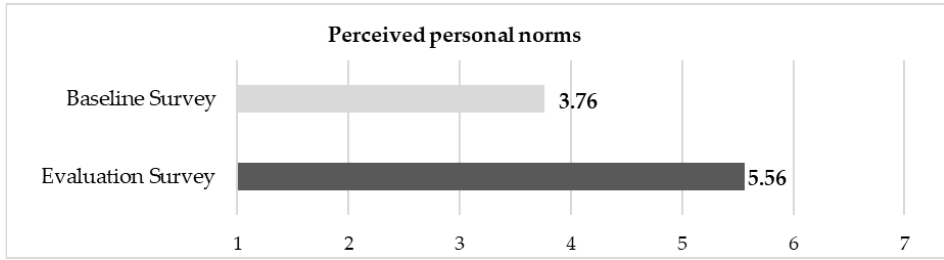
Figure 4. A comparison of perceived personal norms in Greek public buildings (before and after the trial).